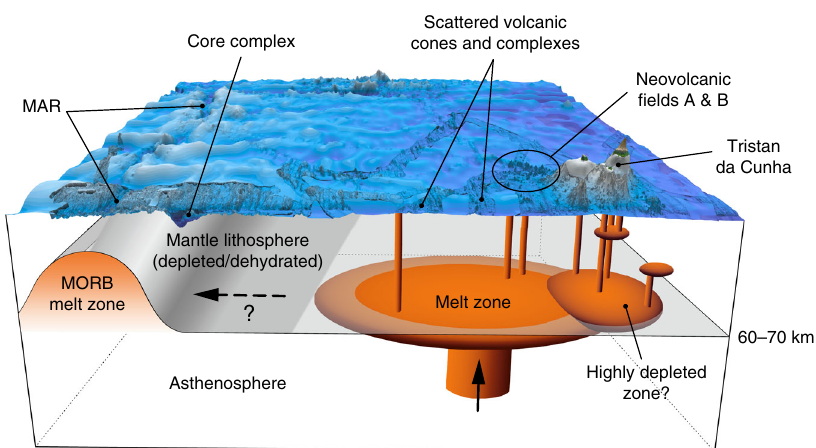
Fig. 10 Schematic model of Tristan da Cunha mantle plume. 3D sketch of the lithosphere and potential mantle plume location SW of Tristan da Cunha. The model is based on Geissler et al. 21 , Humphreys and Niu 50 , and Schloemer et al. 31